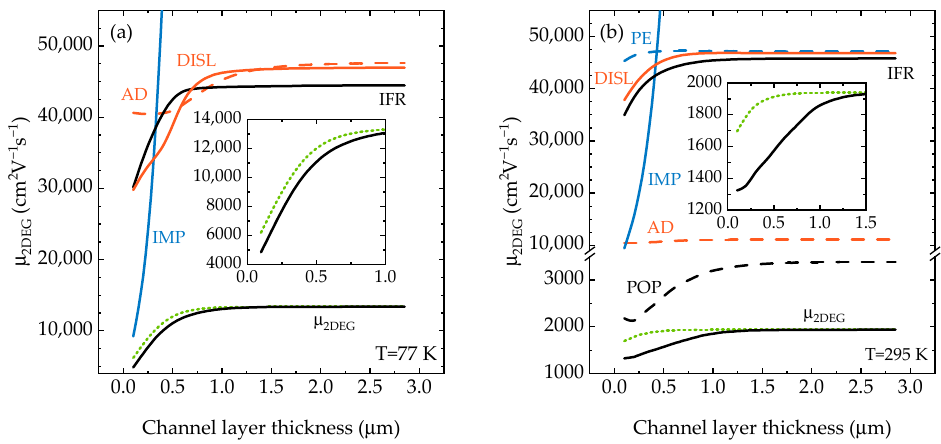
Figure 5. The calculated 2DEG mobilities limited by different scattering mechanisms versus the GaN channel layer thickness at 77 K ( a ) and 295 K ( b ). The green dotted lines show the total mobility, calculated taking into account the differences in IMP scattering only (see text). The insets show µ 2DEG vs. channel layer thickness in more detail.